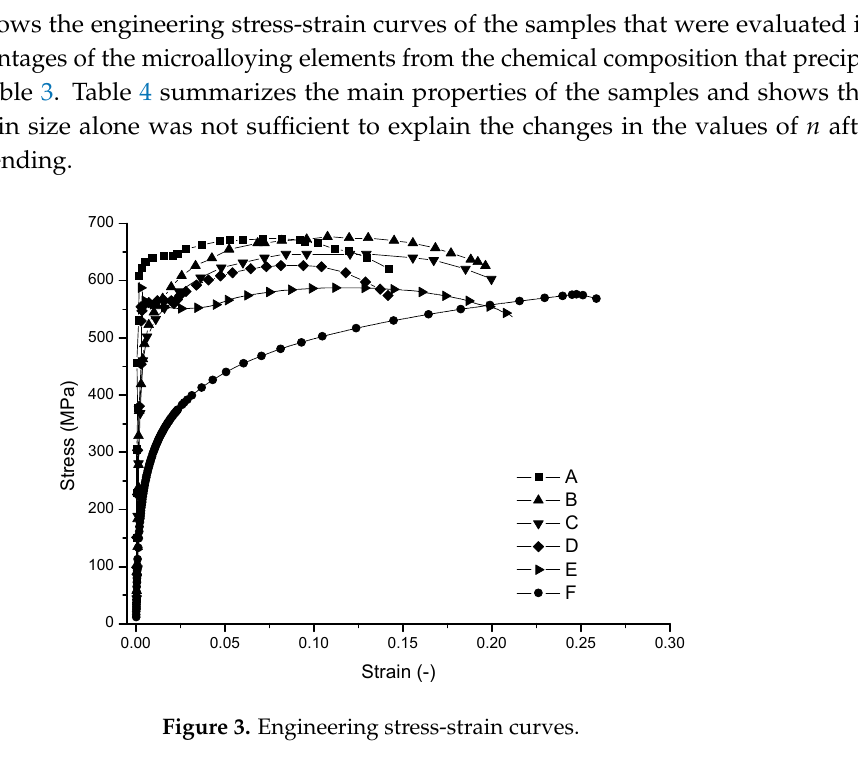
Figure 3. Engineering stress-strain curves. Table 3. Effects of the hot-induction bending and tempering on the percentage of the alloying elements that precipitated.